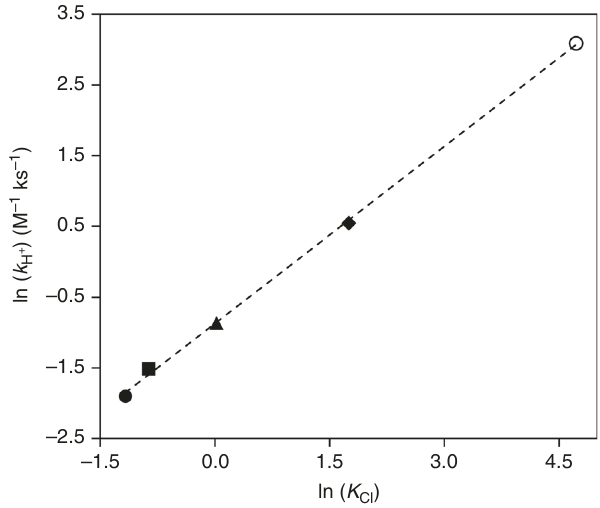
Fig. 3 Fructose conversion rate constant versus K Cl for Cl − transition state formation. Data points represent the following GVL concentrations: 5% GVL (black circle), 25% GVL (square), 50% GVL (triangle), 75% GVL (diamond), and 90% GVL (hollow circle). The black dashed lines represent a linear trendline: y = 0.84 × − 0.87, R 2 = 0.99. Reaction rate constant values: r = k H + [R] [H + ]. K Cl represents the equilibrium constant. Equilibrium constant values (i.e., K Cl ): model fi ts using Equation (7) with data from Fig. 2. Reaction conditions: fructose (50 mM); acid (H 2 SO 4